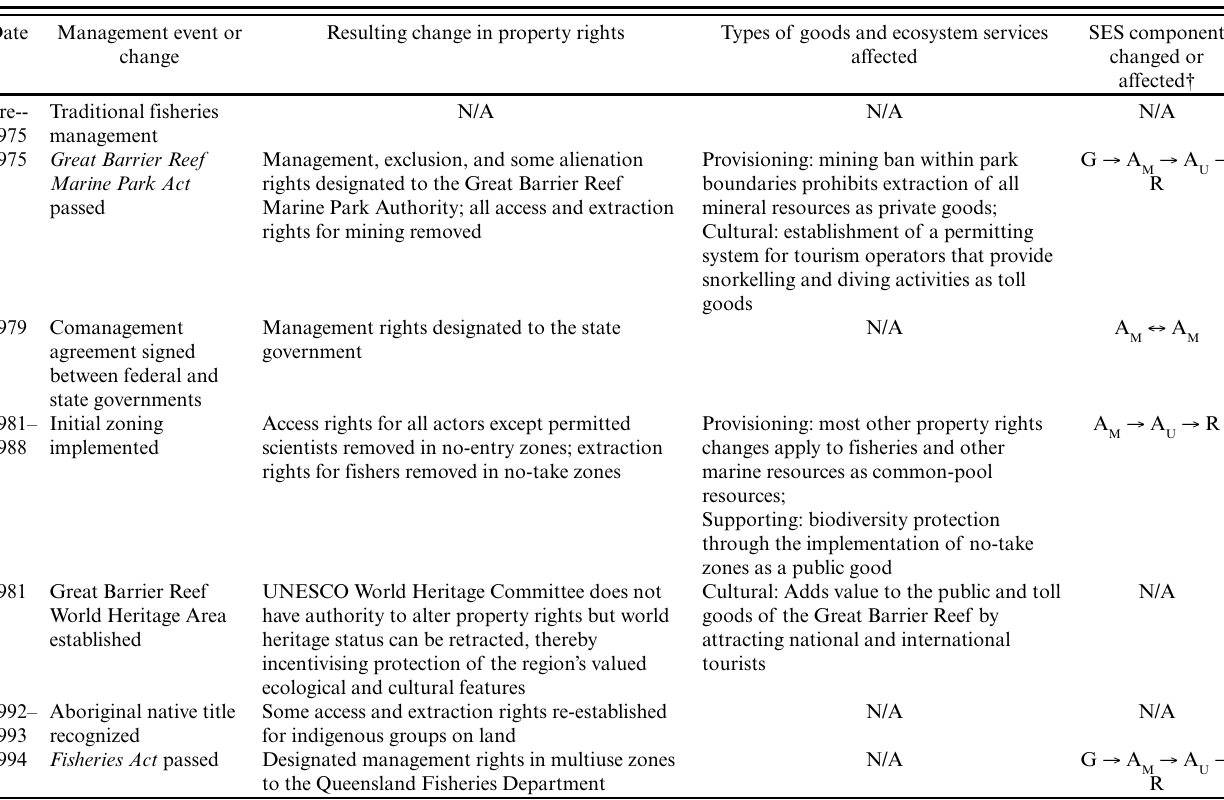
Table 2. Major management changes through time for the Great Barrier Reef Marine Park, and resulting property rights changes: park establishment, 1975 to